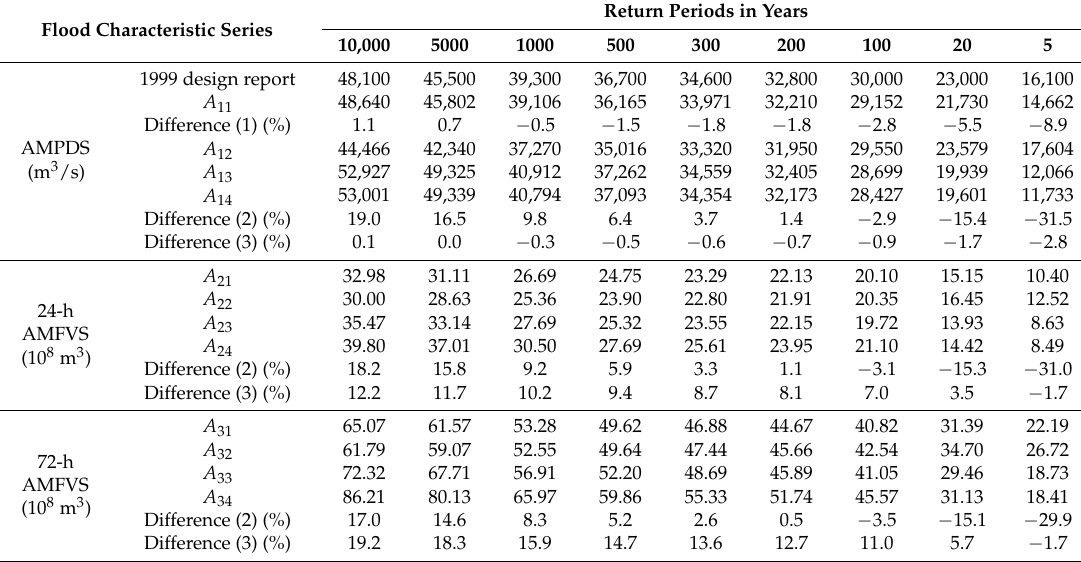
Table 10. Design value of each flood characteristic